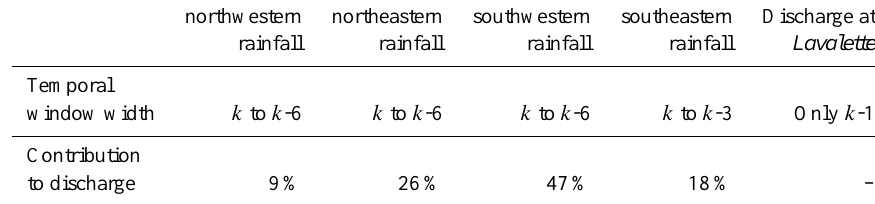
Table 2. Temporal window width and contribution of each zone to discharge at Lavalette .